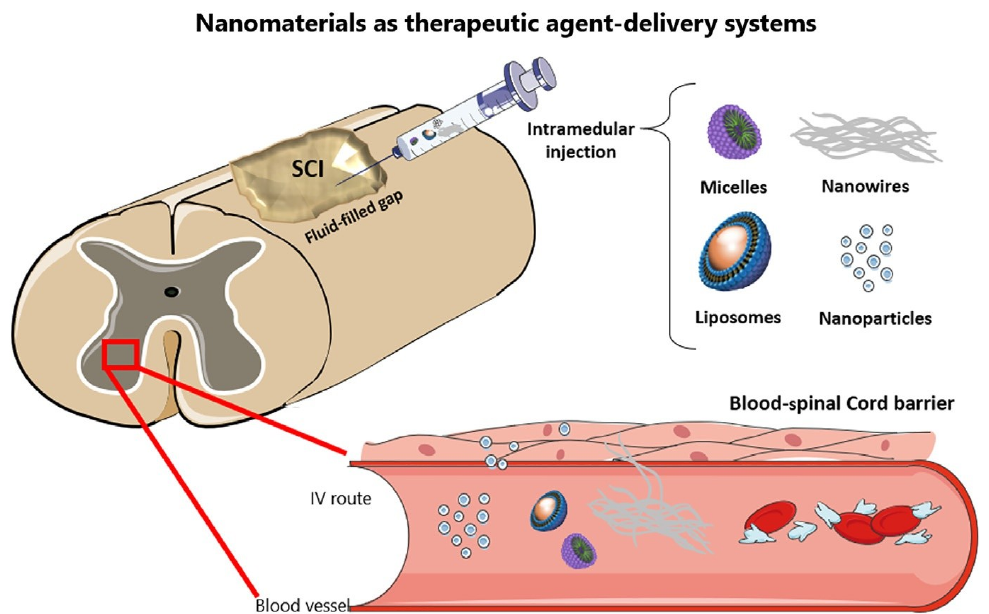
Figure 6. Different nanomaterials as drug delivery systems for the treatment of SCI. One of their most important features is their small size (nanoscale), which makes them capable of crossing the blood spinal cord barrier. Adopted from [151], with permission from Elsevier Limited 2019.